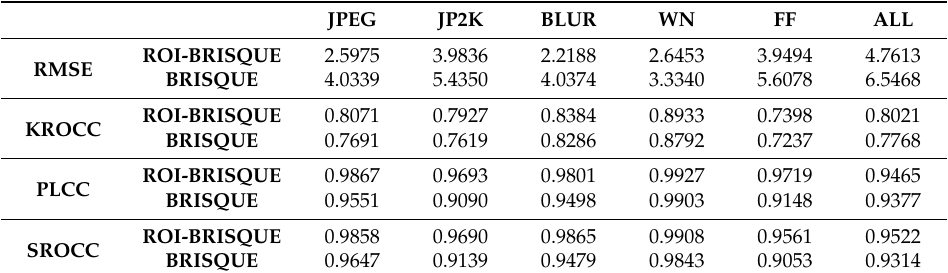
Table 5. Performance comparison of different distortion